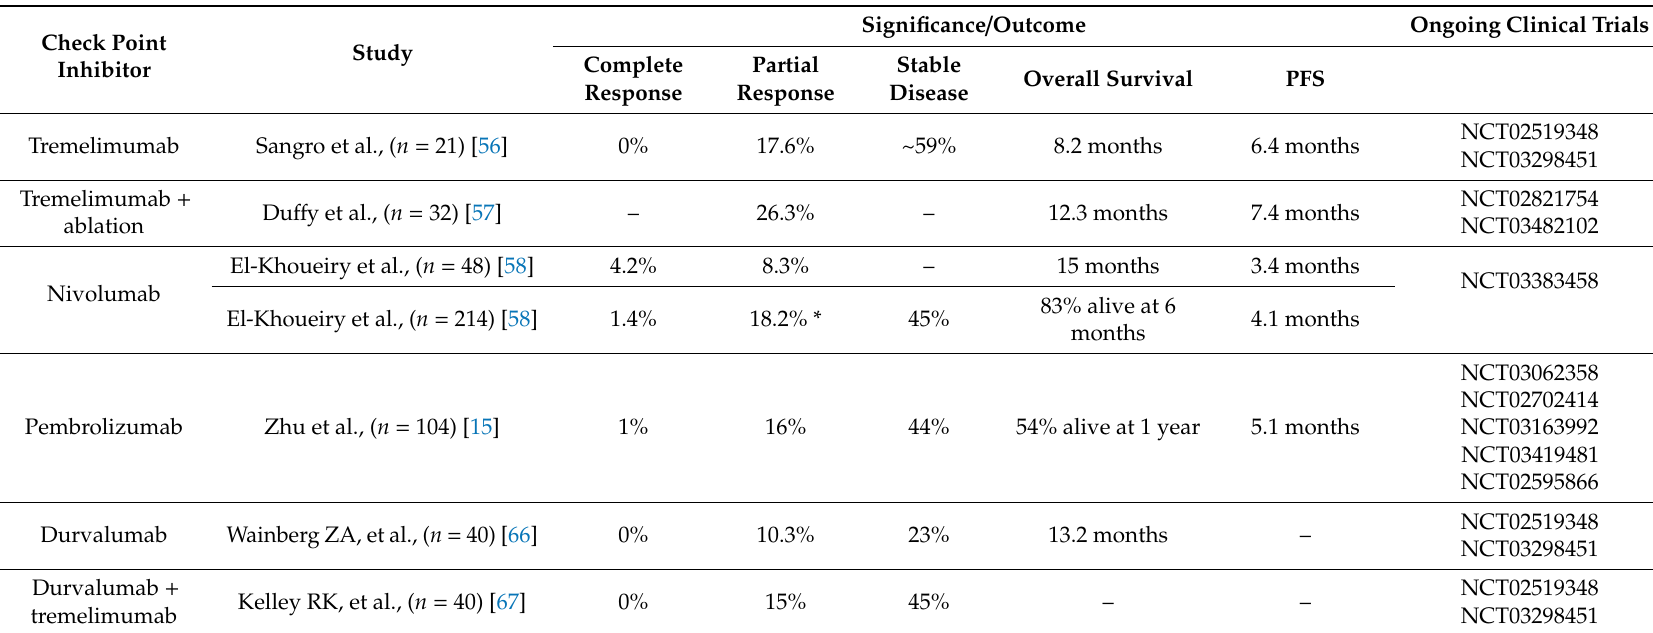
Table 1. Key clinical trials of immune checkpoint inhibitors in hepatocellular